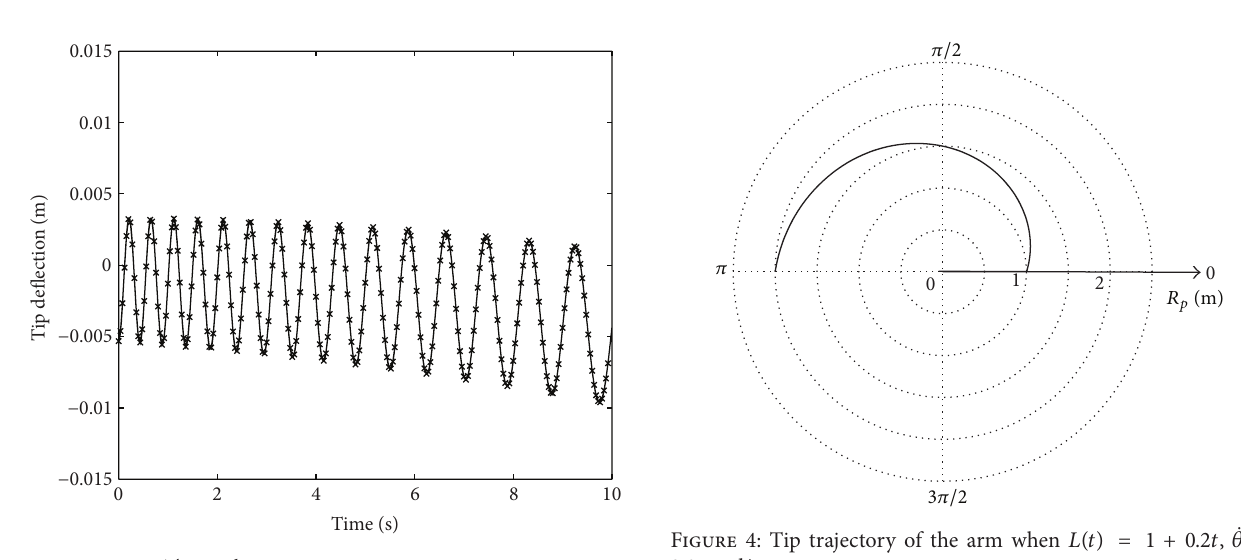
Figure 4: Tip trajectory of the arm when 𝐿(𝑡) = 1 + 0.2𝑡 , 0.2𝜋